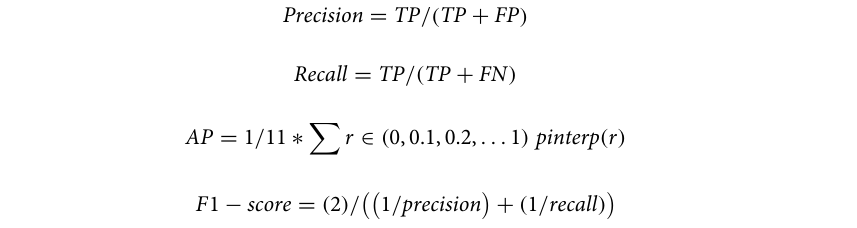
Figure 6. Labels and label distribution, ( a ) number and class of labels in the dataset, ( b ) location of the labels in the images of the dataset and the size of the labels in the dataset, ( c ) ground truth leaf rust, black rot, and tea mosquito, respectively, 2% of the time, which caused the most confusion when clas- sifying diseases. Comparison of models. The experimental results included four outcomes: true positive (TP), which refers to the accurate detection of individually marked diseased leaves; false positive (FP), which refers to an object that was incorrectly identified as a diseased tea leaf; true negative (TN) which refers to negative samples with a negative system prediction; and false negative (FN) which refers to diseased tea leaves that were overlooked. The YOLOv7 model of this present study is compared with YOLOv5 to confirm its accuracy and efficacy. Table 2 compares mAP, precision, recall, and training time between YOLOv7 and YOLOv5. Precision refers to the pro- portion of correctly recognized tea leaf diseases across all images. The recall rate is the proportion of accurately recognized diseased leaves in the dataset. The only challenge we encountered with the YOLOv7 model was that it required more time to train, whereas the YOLOv5 model required less. The other parameters (Table 2) are higher than YOLOv5. Prominent statistical Metrics are calculated using the following equations 35 .